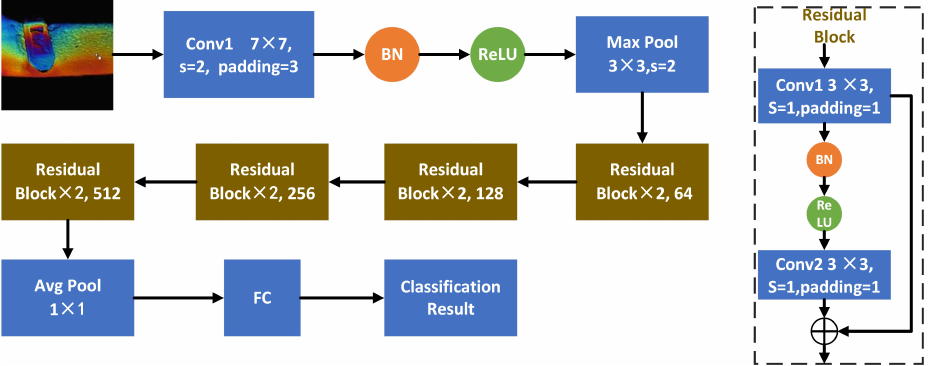
Figure 3. The structure of